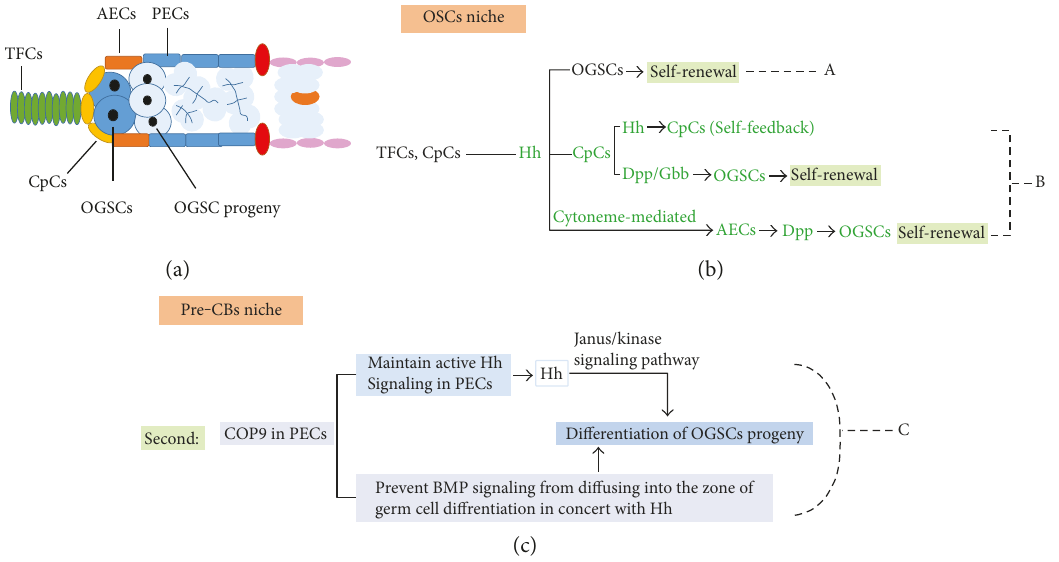
Figure 2: E ff ect of the Hh signaling pathway on the regulation of proliferation and di ff erentiation of OGSCs in Drosophila . (a) OGSCs and their progeny are located in a niche that is composed of various somatic cells. (b) (A) Hh secreted from TFCs and CpCs can promote the self-renewal of OGSCs directly. (B) Hh originating from TFCs and CpCs can promote CpCs and AECs to secrete Gbb or Dpp, which is indirectly bene fi cial for the self-renewal of OGSCs. (c) (C) COP9 is important for maintaining the activity of the Hh pathway in PECs. The COP and Hh axis helps to prevent Dpp from di ff using. Moreover, COP9 can downregulate Dpp expression in PECs. A low concentration of Dpp antagonizes OGSC progeny di ff